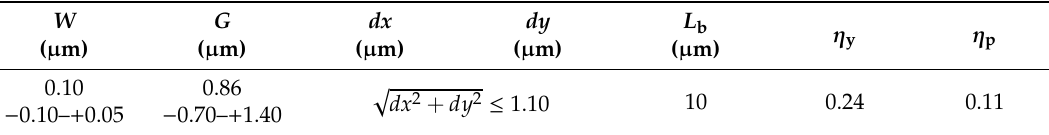
Table 2. Characteristics of the Y-branch coupler.